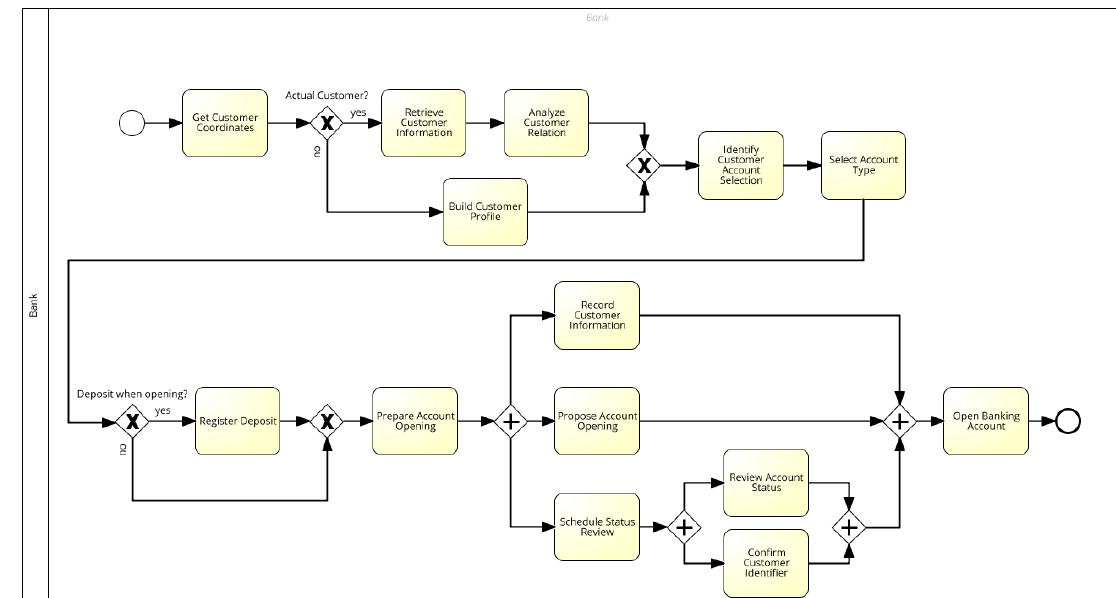
Figure 4. An example of an equivalent model to the spreadsheet-based process description presented in Table